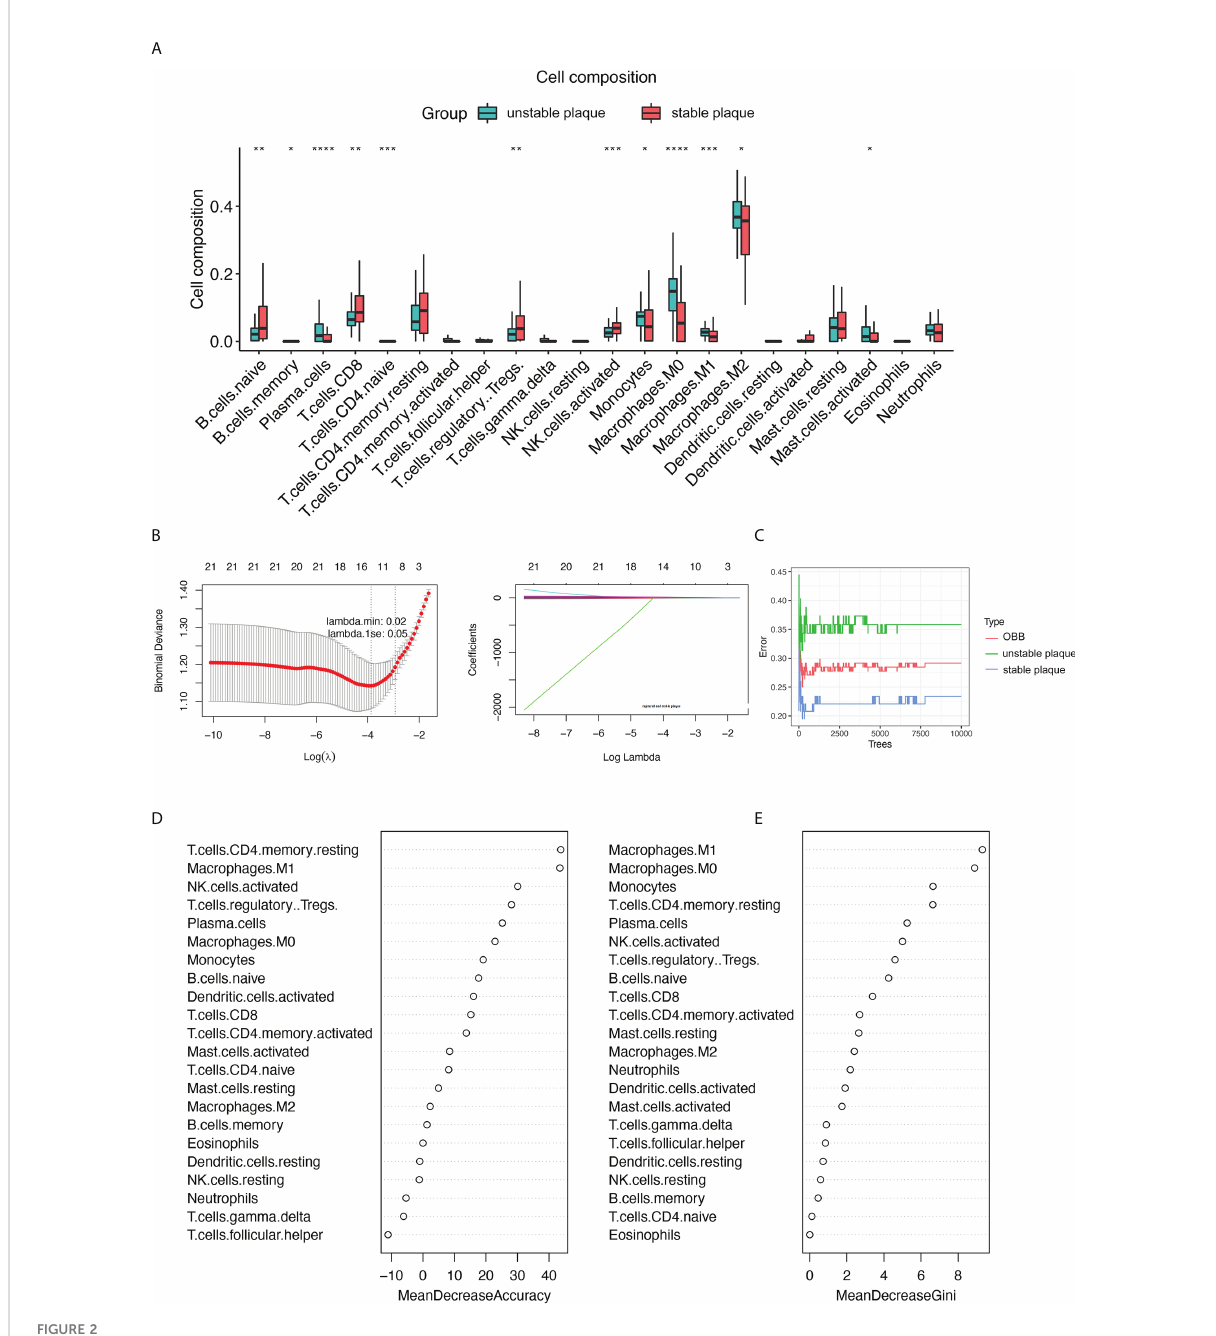
FIGURE 2 | Identi fi cation of key immune cell types associated with the stability of carotid plaques. (A) Identifying the signi fi cantly different in fi ltrates of immune cells in unstable and stable plaques by Wilcoxon test. (B) LASSO regression was conducted to analyze the different in fi ltrates of immune cells in unstable and stable plaques. (C – E) RandomForest was conducted to analyze the different in fi ltrates of immune cells in unstable and stable plaques. Key immune cell types associated with the stability of carotid plaques were identi fi ed by mean decrease accuracy (D) and mean decrease Gini (E) . * p < 0.05; ** p < 0.01; *** p < 0.001; **** p <